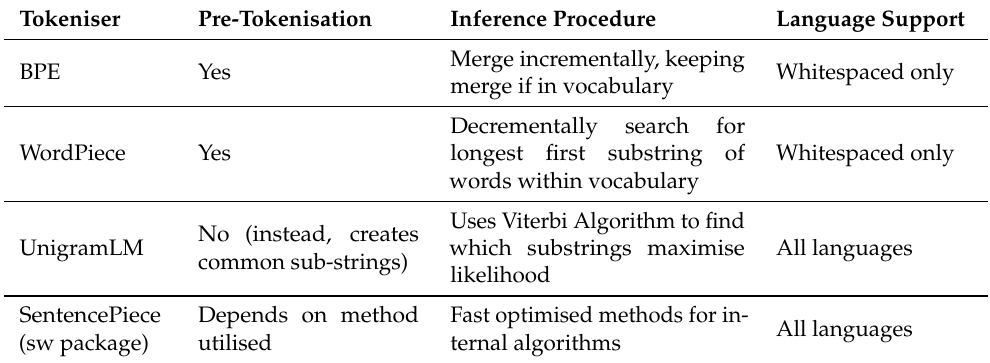
Table 1. Overview of modern tokenisation approaches. SentencePiece is included, but should not be mistaken as a separate